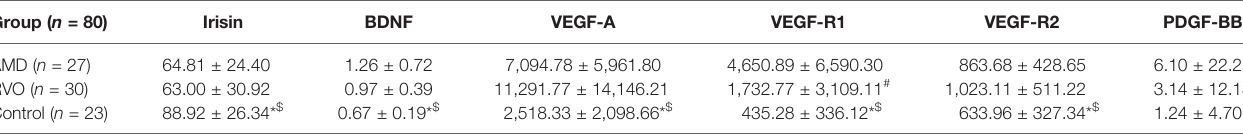
TABLE 2 | The levels of irisin, BDNF, VEGF-A, VEGF-R1, VEGF-R2, and PDGF-BB in the aqueous humor. Group ( n = 80)